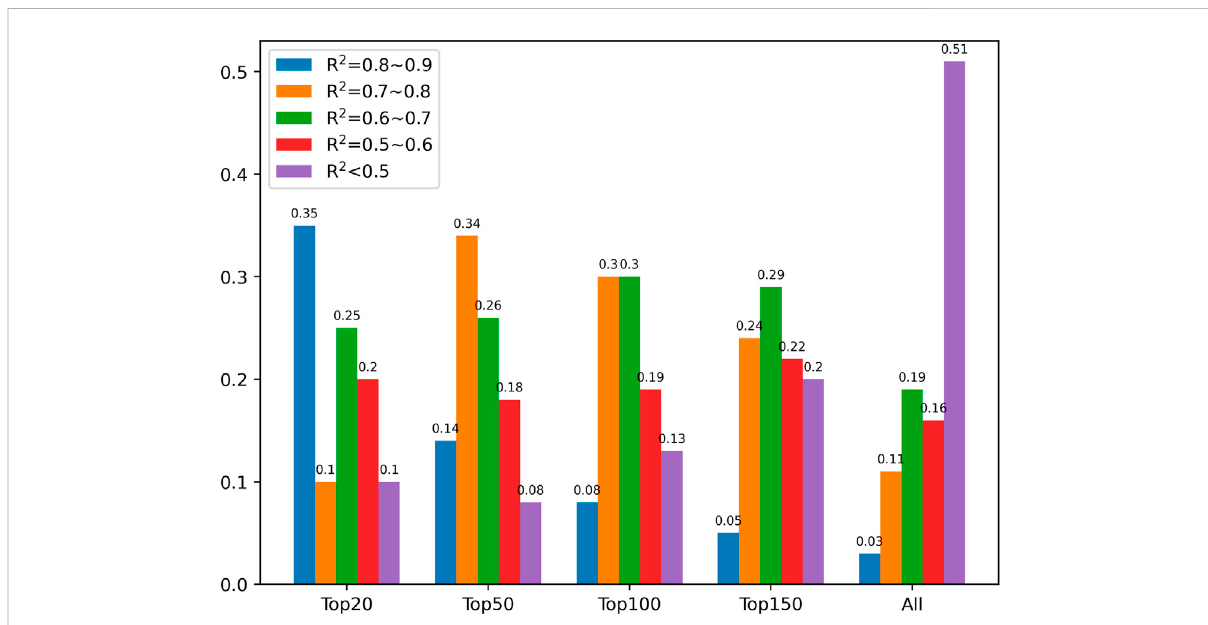
FIGURE 5 The proportion of cities with R 2 values in the top 20, top 50, top 100, and top 150 of SO 2 pollution cities and all cities in eastern China from 2016 to 2020.